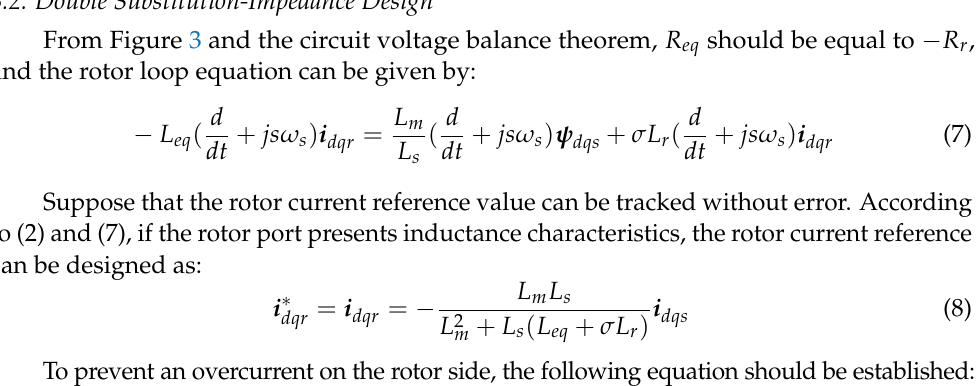
Figure 5. Equivalent circuit of the rotor side under the proposed strategy.